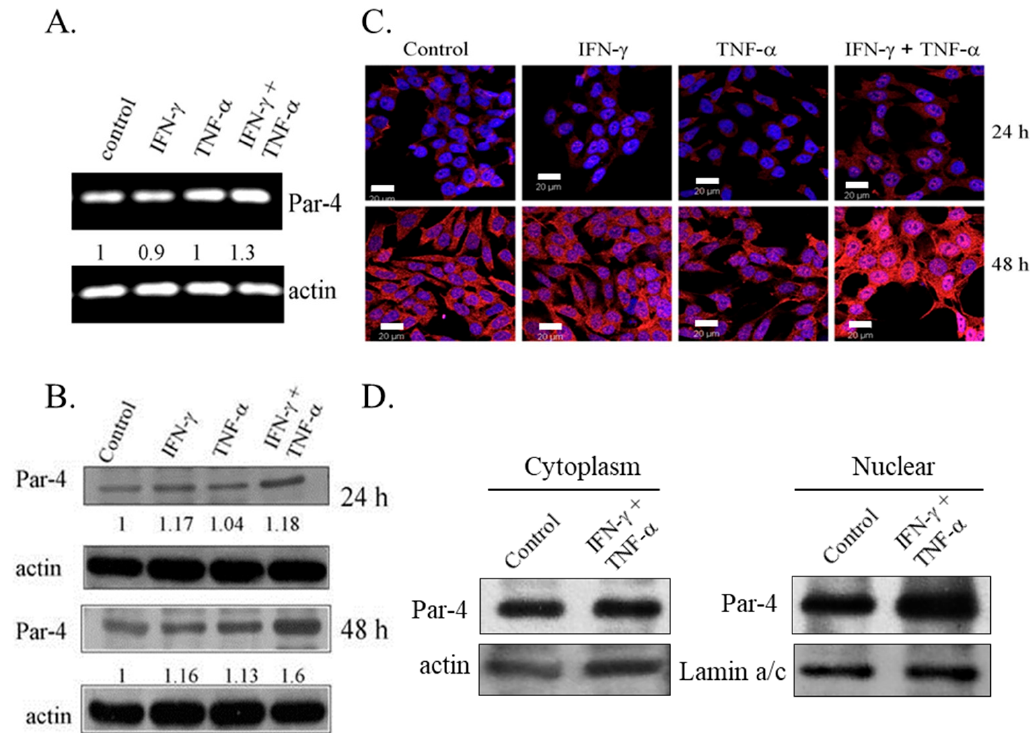
Figure 3. Combination of IFN- γ and TNF- α up-regulates the expression of Prostate apoptosis response-4 (Par-4). SK-N-MC cells were treated with IFN- γ (10ng/mL) and TNF- α (20 ng/mL) alone and in combination and analyzed for the expression of Par-4 by: ( A ) RT-PCR; ( B ) immunoblotting. Actin was used as loading control in both; ( C ) Immunofluorescence shows merged images with Par-4 (red) and nucleus (blue); Bar = 20 µm and ( D ) Immunoblotting represents level of Par-4 in cytoplasmic, and nuclear fraction of SK-N-MC cells at 48 h with actin and lamin-a/c as loading control, respectively.